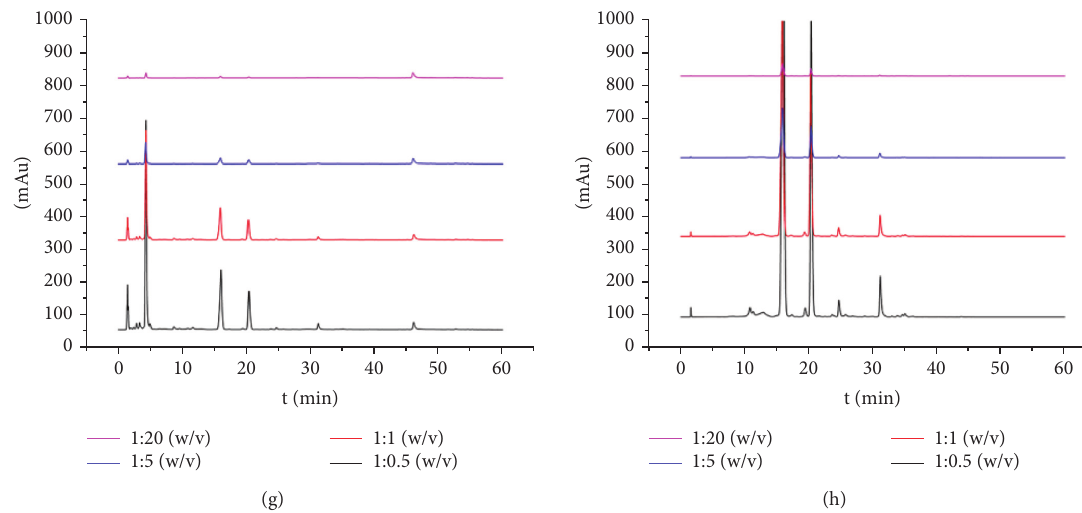
Figure 1: Effect of extraction solvent (a, b), extraction time (c, d), light (e, f), and solid-liquid ratio (g, h) on the HPLC fingerprints of saffron at 257nm (a, c, e, g) and 440nm (b, d, f, h).